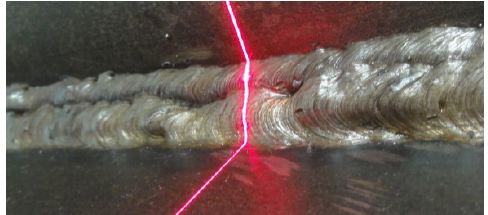
and Klimentjew et al. (2010) or, as done in this case, be provided by an additional camera system.